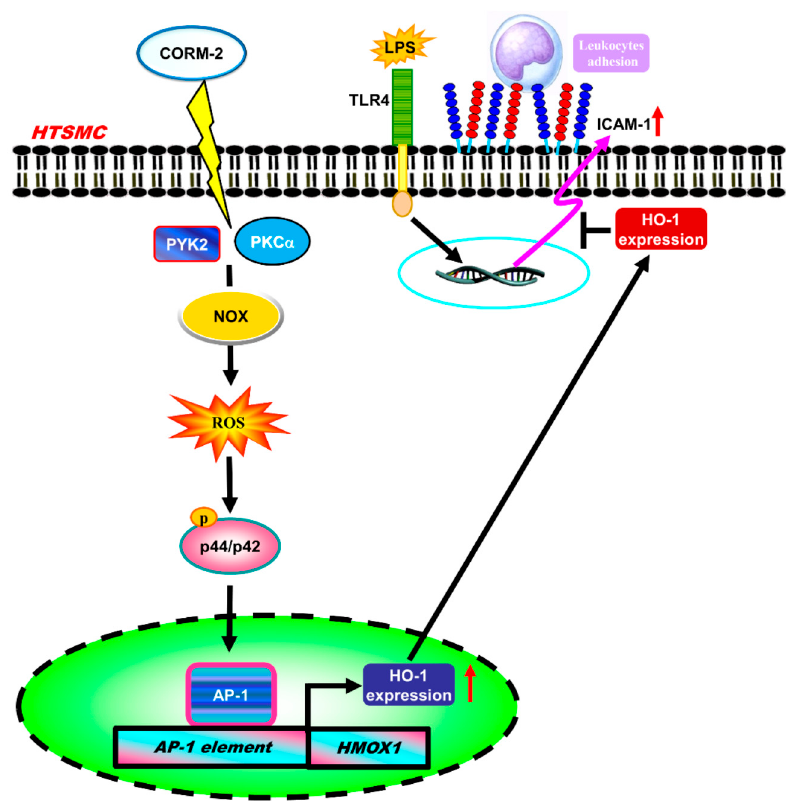
Figure 9. Schematic signaling pathways are involved in CORM-2-induced HO-1 expression in HTSMCs. CORM-2-induced HO-1 expression is mediated via a PKC α or Pyk2/Nox/ROS/ERK1/2 cascade linking to activation of c-Fos and c-Jun/AP-1. The up-regulation of HO-1 could protect against the LPS-induced airway inflammation.